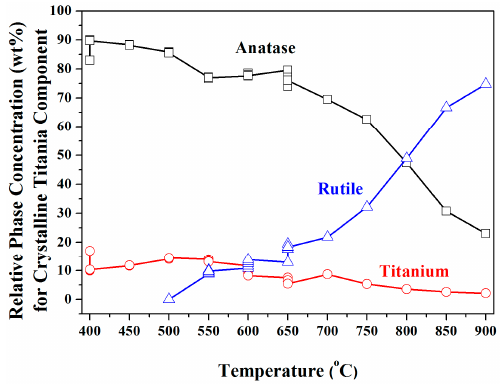
Figure 6. Phase abundances of titanium, crystalline anatase and crystalline rutile for anodized titania nanotube arrays calcined at 400–900